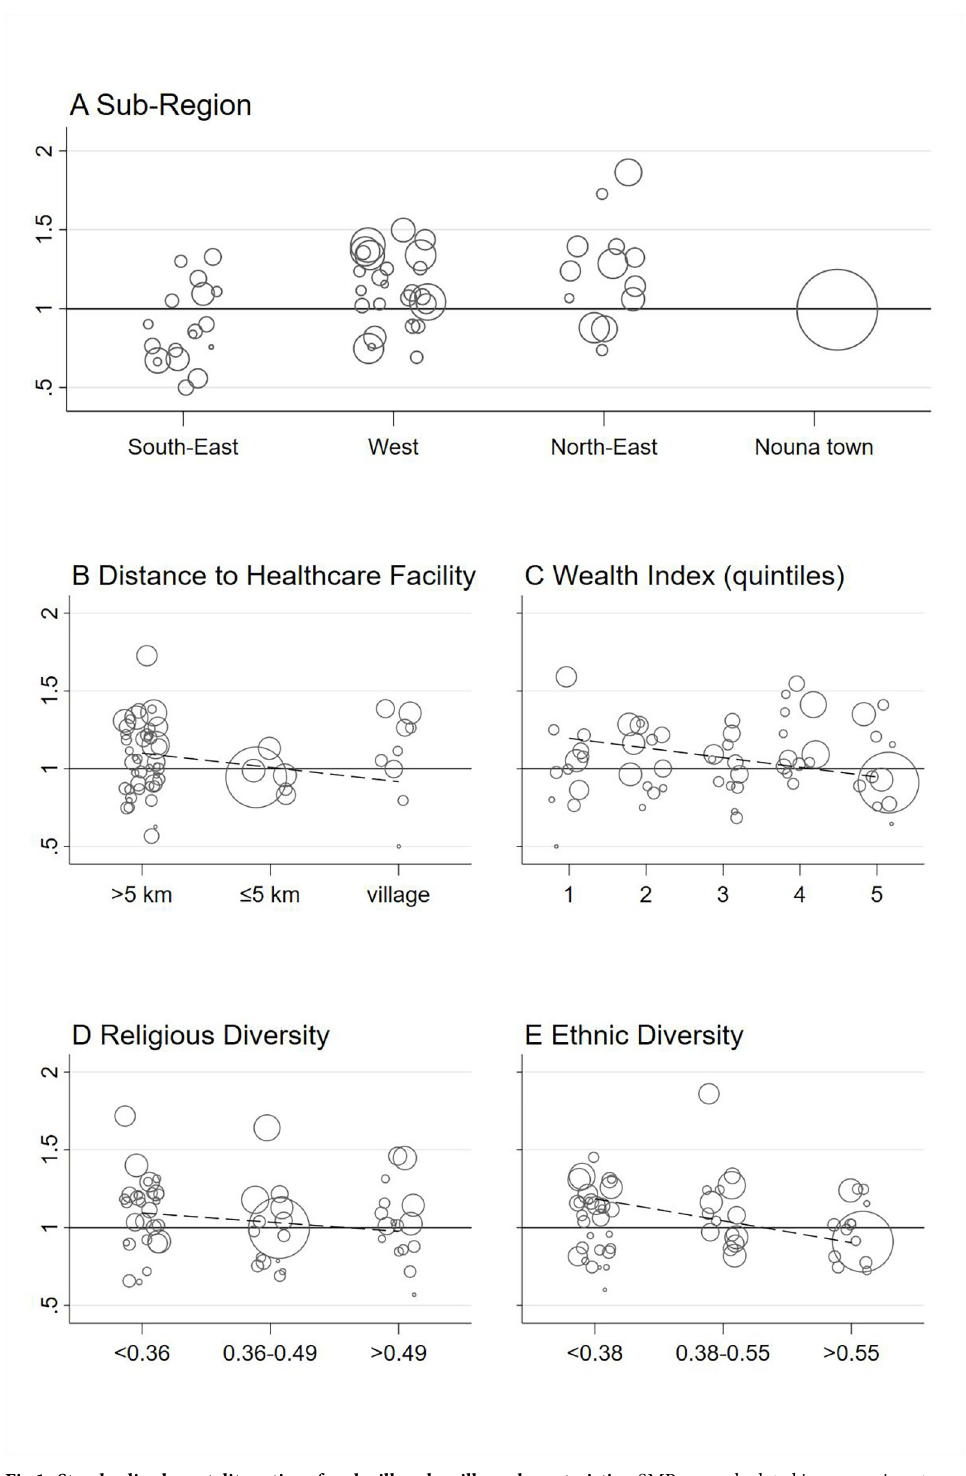
Fig 1. Standardized mortality ratios of each village by village characteristics. SMRs are calculated in comparison to the entire HDSS, the bubble size indicates the number of observed deaths, dashed lines indicate linear trends (weighted by the number of observed